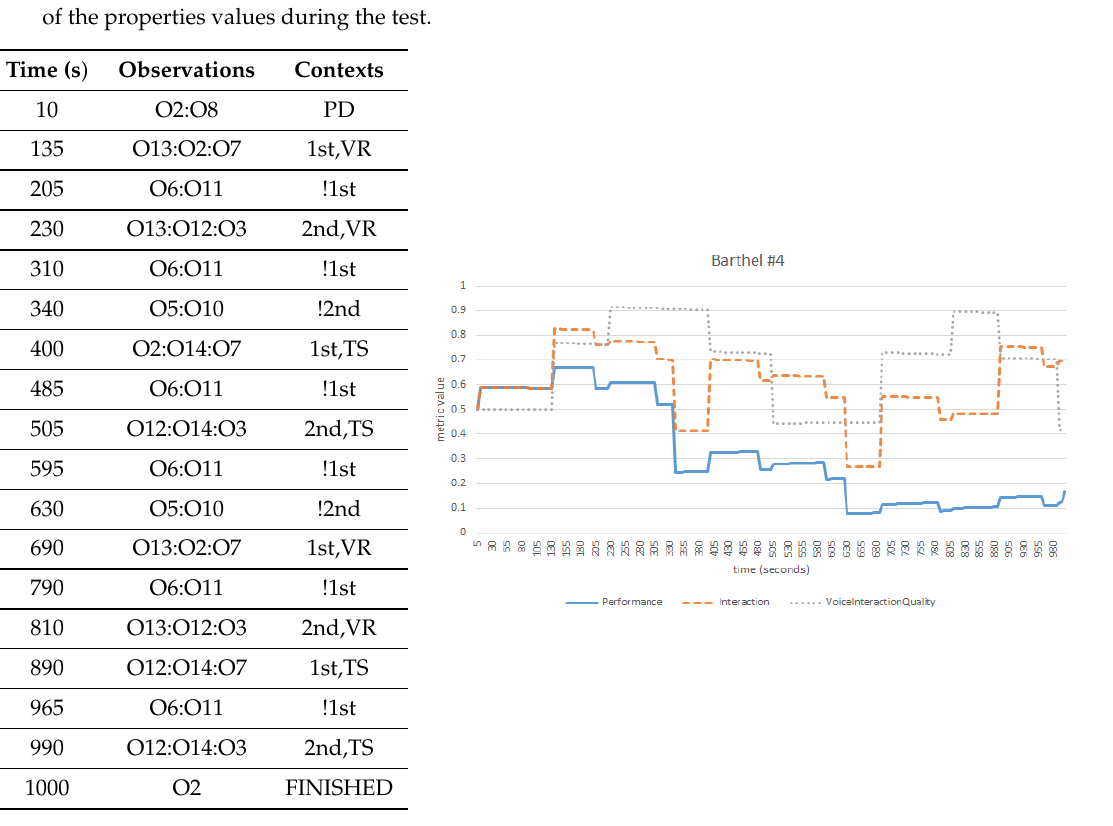
Table 4. Barthel #4: (Left) Contexts and observations generated by the system. PD (PersonDetected), 1st (FirstAttemptAnswered=true), !1st (FirstAttemptAnswered=false), 2nd